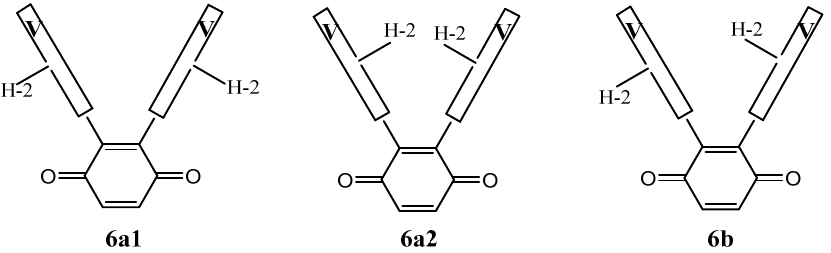
Figure 3. A simplified representation of compounds 6a1 , 6a2 and 6b .